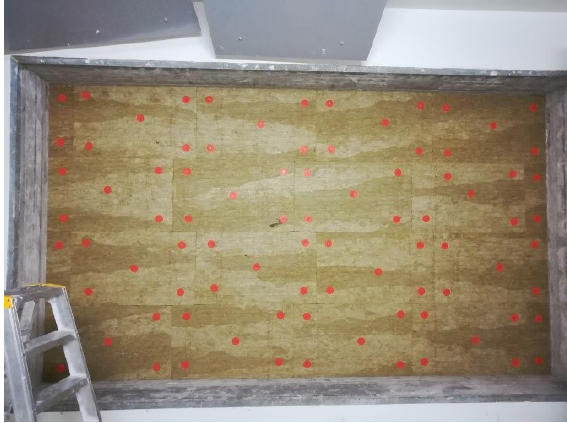
Figure 8. Mineral wool boards of ETICS fastened with anchors.